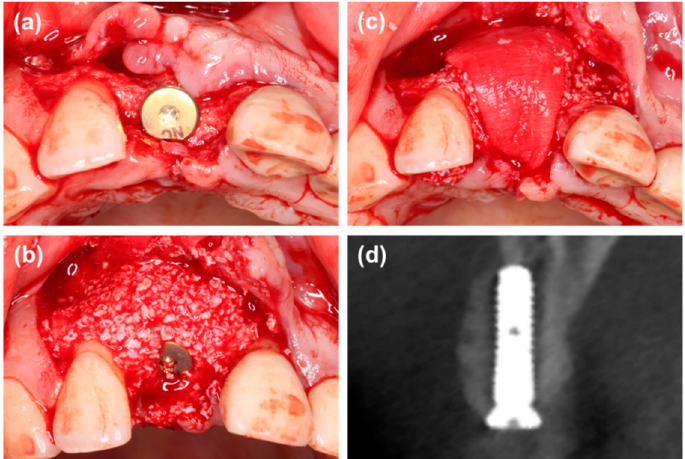
Figure 2. ( a ) The labial defect could be observed, and a wide healing cap was connected to the implant. ( b , c ) Guided bone regeneration with particulate bone substitutes and collagen mem- brane. ( d ) Radiographic view of cone beam CT immediately after wound closure. Group 3: Cortical perforation was performed following flap elevation. For the pa- tients with simultaneous implant placement, a cover screw was connected to the implant after implant placement. Blood was taken from the elbow vein and centrifuged at 700 rpm for 3 min to obtain i-PRF. Then particulate bone substitutes were mixed with i-PRF to form sticky bone [13]. The sticky bone was placed into the defect to achieve 1 mm of over-aug- mentation and covered with a collagen membrane. In addition, titanium pins were used to fixate the membrane (Figure 3).